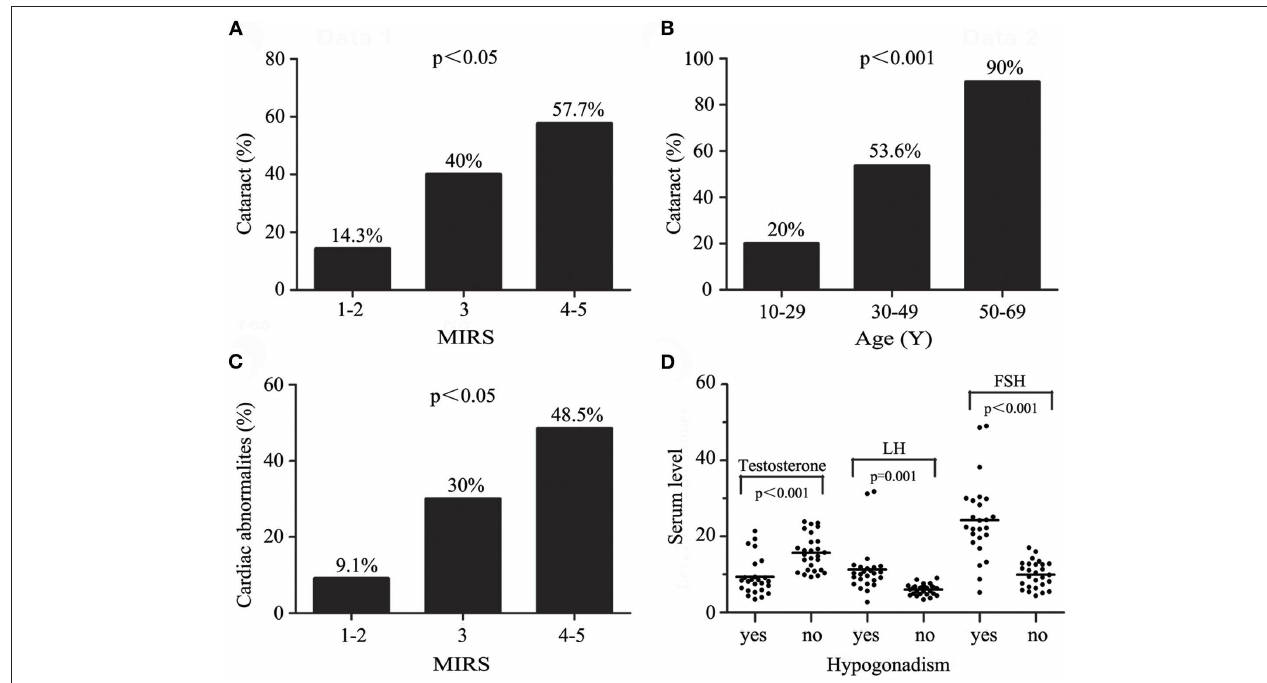
FIGURE 3 | (A) The prevalence of cataract increases with MIRS. (B) The prevalence of cataract increases with age. (C) Progression of cardiac abnormalities with increasing MIRS. (D) Comparison of testosterone, LH and FSH levels in male patients with or without hypogonadism.